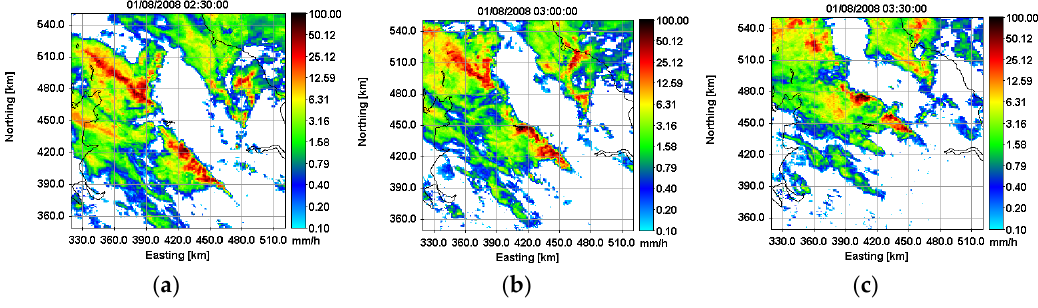
Figure 2. Radar scan at 02:30 ( a ), 03:00 ( b ) and 03:30 ( c ) on 1 August 2008.